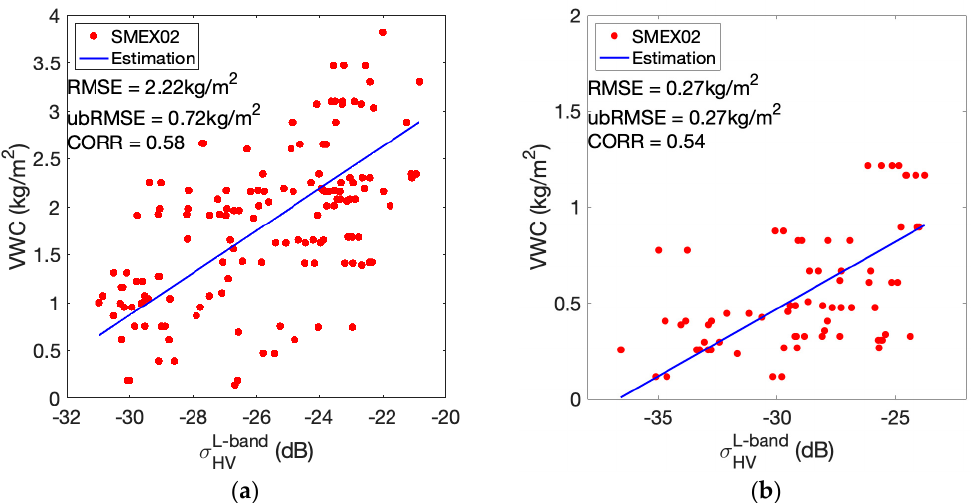
Figure 4. Comparison of NDWI derived VWC of SMEX02 (red dots, reference) and the estimated VWC (blue line) derived using the SMEX02 L-band HV and the SMAPVEX12 regression coefficients, Equations (1) and (2): ( a ) corn ( b ) soybean. Table 2. Comparison of VWC derived from NDWI and VWC sampled from in situ during flight period. The label flight (F) stands for days the radar measurements were taken. The label sampling (S) stands for days when VWC samplings were taken in fields.